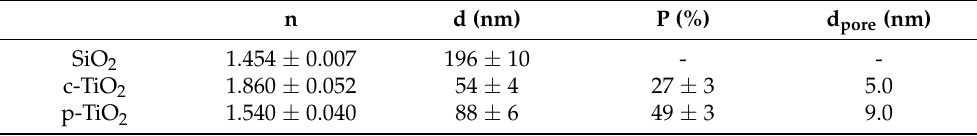
Figure 1. ( a ) Transmittance spectra of the SiO 2 coated glass substrate, the different TiO 2 coatings and the TiO 2 –Ag composite coatings on the example of p-TiO 2 type samples; ( b ) Tauc plots of samples prepared on quartz glass. Table 1. Refractive index (n), film thickness (d) and porosity (P) values of SiO 2 barrier layer on glass, and the different TiO 2 layers deposited on SiO 2 coated glass. Average pore size values (d pore ) are included from our previous publication [18], determined by ellipsometric porosimetry on samples prepared by dip-coating on Si wafers.